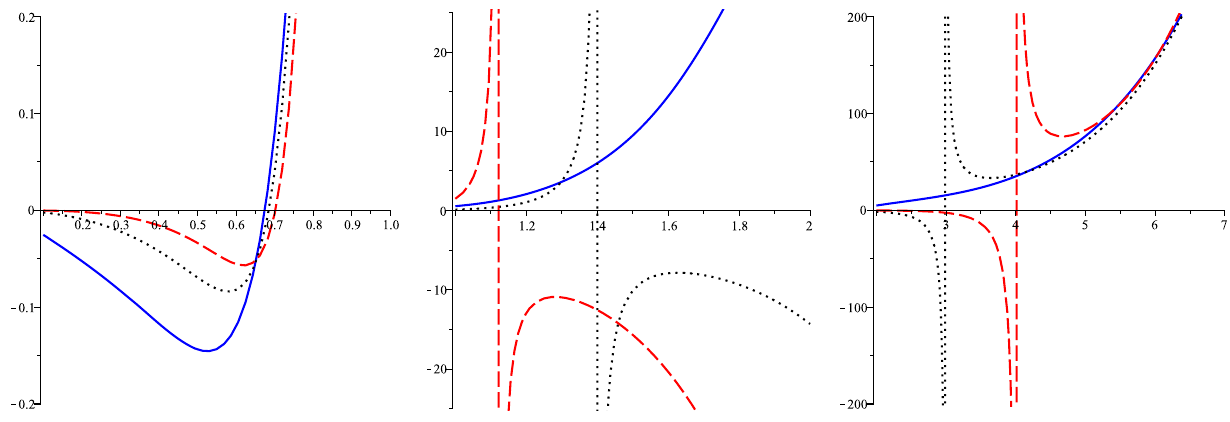
Fig. 10 C P , X versus r + for k = 1, q = 1, α = 1, P = 1 / 8 π , m = 0 . 1, c 0 = c 1 = c 2 = c 3 = c 4 = 1 and d = 7 (solid line), d = 8 (dotted line) i and d = 9 (dashed line). Different scales: left panel (0 < r + < 1), middle panel (1 < r + < 2) and right panel (2 < r + < 7)